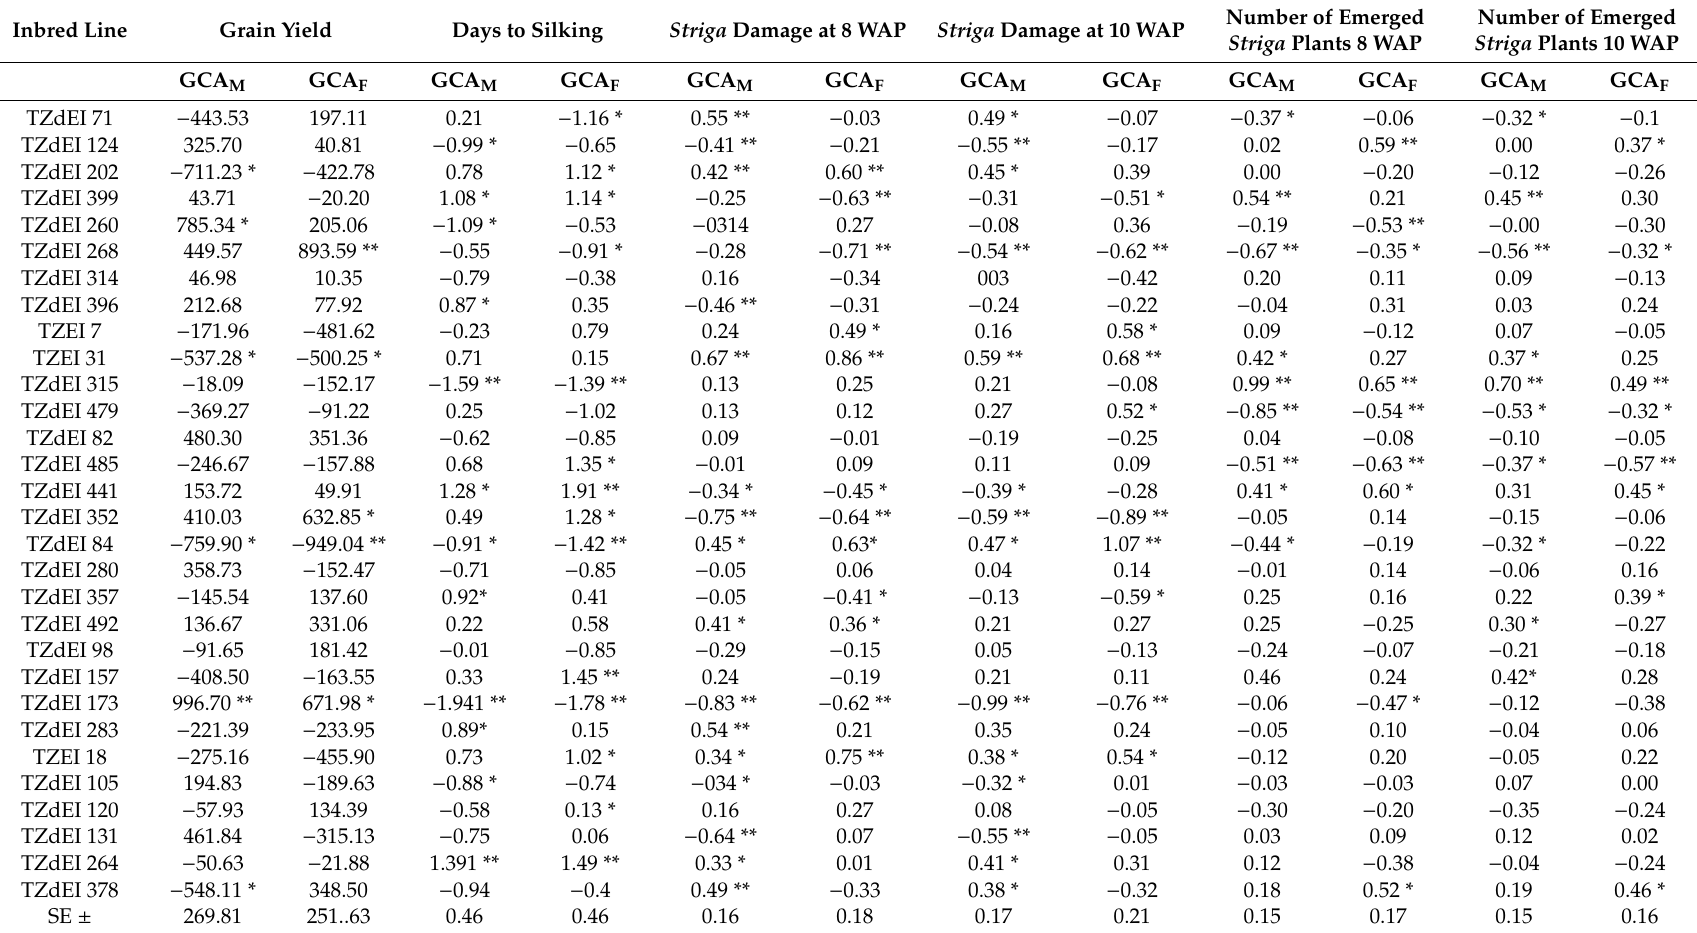
Table 5. General combining ability e ff ects of early maturing inbred lines evaluated under Striga -infested